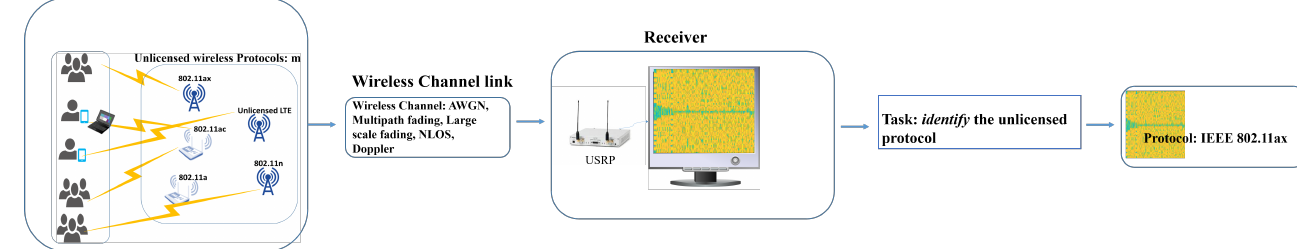
Figure 1. Emitter classification system